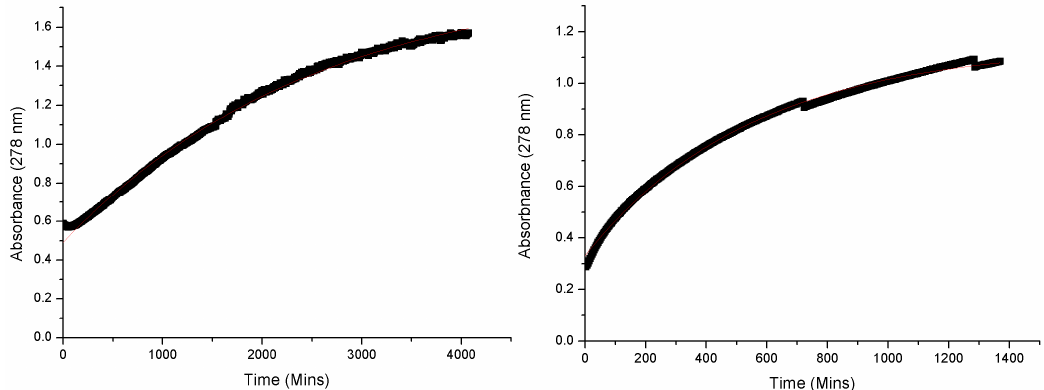
Figure 2. Absorbance at 278 nm recorded during the homocoupling reaction of 150 μ M 1 in aqueous pH 8 borate buffer (10 mM) and catalyst Pd ‐ PPy ‐ PS (1.8 μ M Pd) over the course of 72 h at 30 °C ( left ) and 70 °C ( right ).